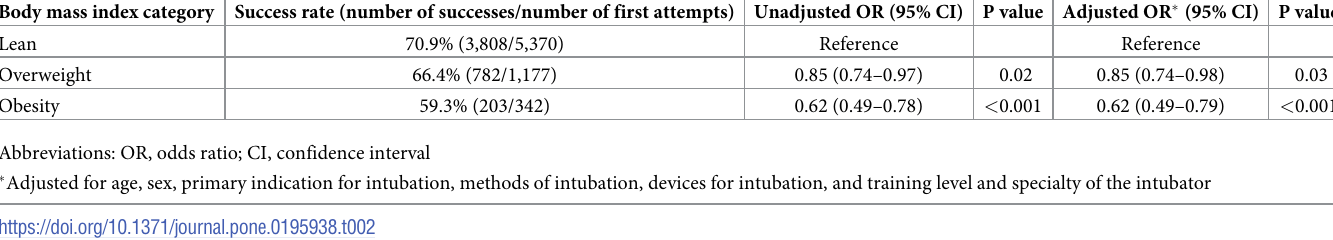
Table 2. Unadjusted and adjusted associations between body mass index and success rates on the first intubation attempt. Body mass index category Success rate (number of successes/number of first attempts) Unadjusted OR (95% CI) P value Adjusted OR (cid:3) (95% CI) P value